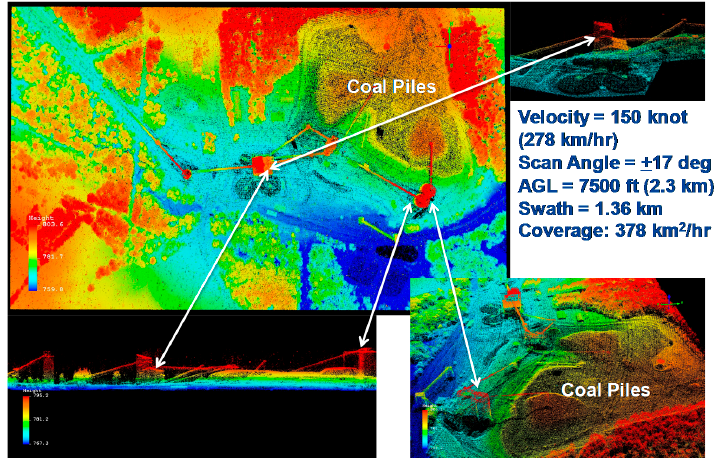
Figure 9. A Garrett County coal mine in which buildings, conveyor belts, and even black coal piles are clearly visible. Elevation Scales: Top Left red = 803.4 m, blue = 759.8 m; Bottom Left and Bottom Right red = 795.2 m, blue = 767.3 m.